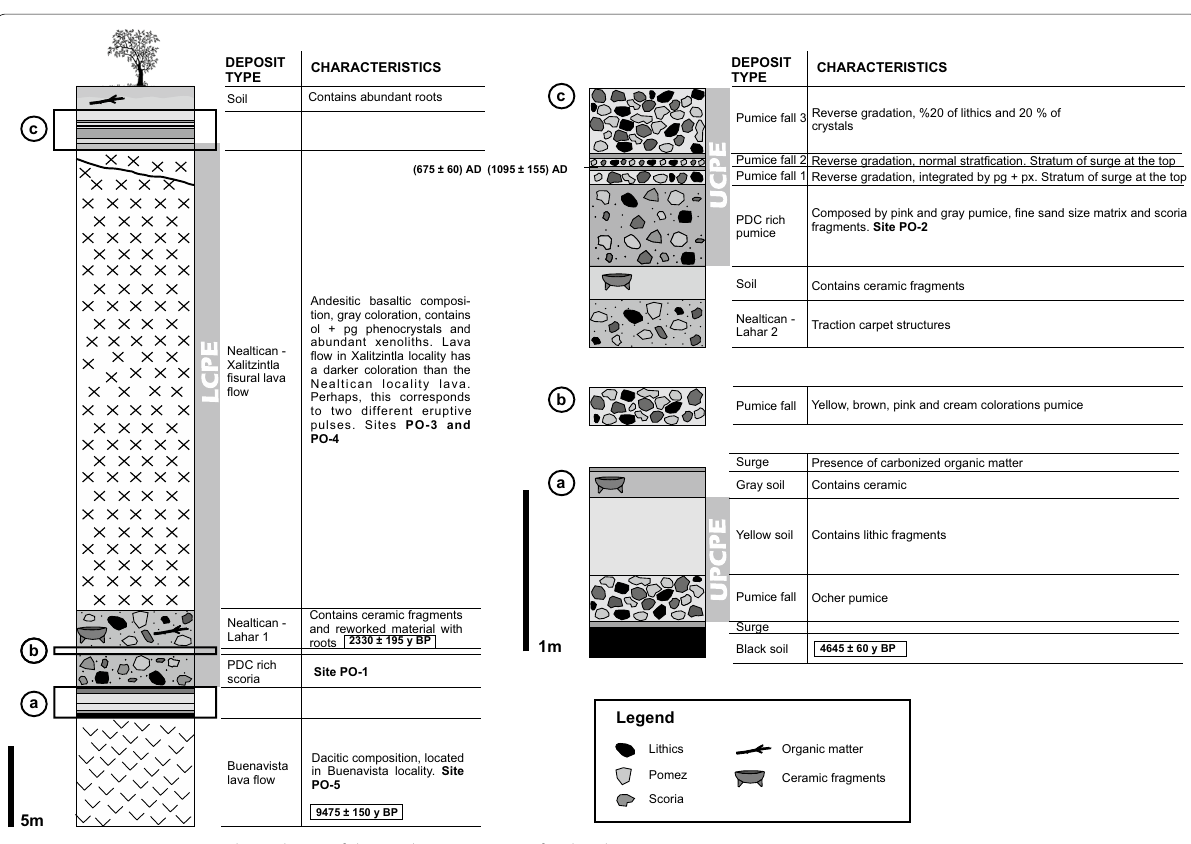
Fig. 2 Composite stratigraphic column of the study area. See text for details